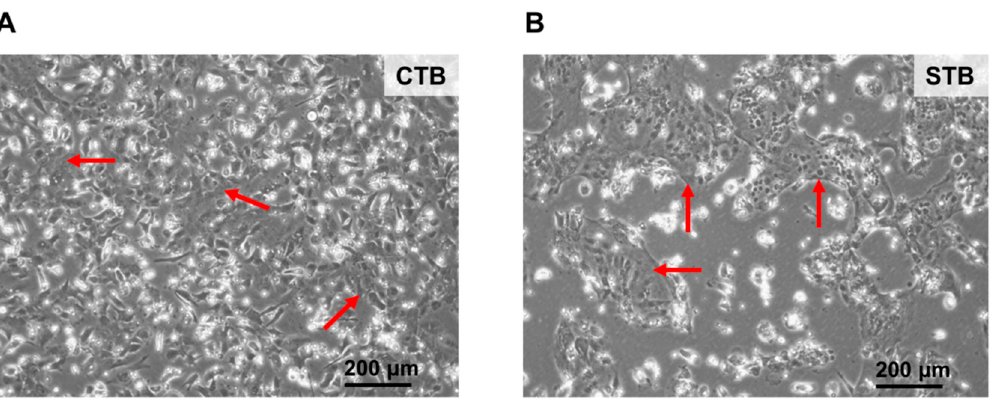
Figure 1. Morphology of trophoblast cells. ( A ) Primary undifferentiated cytotrophoblasts (CTB) were cultured as described in Materials and Methods. After 24 h cultivation cells show characteristics of mononucleated epithelial cells with well-demarcated cell borders and large nuclei as highlighted by the red arrows; and ( B ) after 3 days of cultivation CTB fused to form multinucleated entities representing a syncytium (STB) as indicated by the red arrows. STB appear as a single continuous layer without cell borders. Bright field images were captured at 10 × magnification. Trophoblasts were isolated from a healthy human placenta at term.